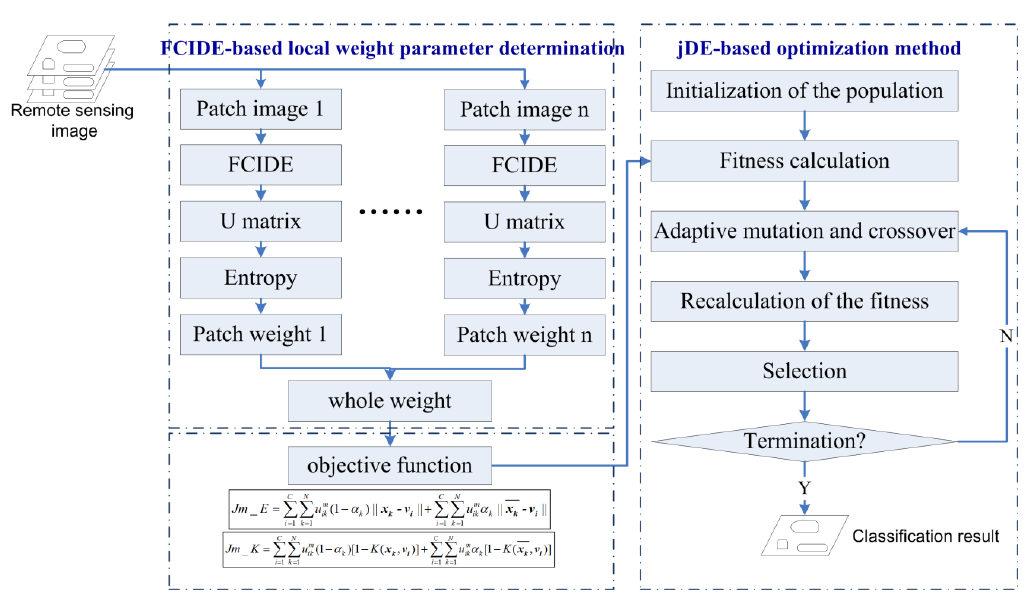
Figure 3. The weight parameter images of adaptive determination method (KADESFC) (circles and lines representing building and roads). ( a ) Wuhan TM image; ( b ) Fancun image; ( c ) the weight parameter image of Wuhan TM image; and ( d ) the weight parameter image of Fancun image.